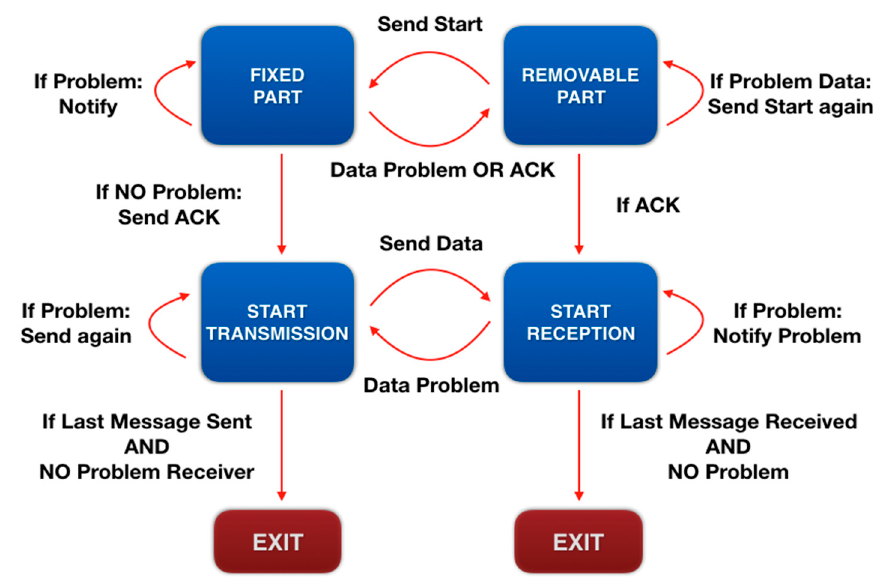
Figure 6. The communication flow block diagram developed for our system.